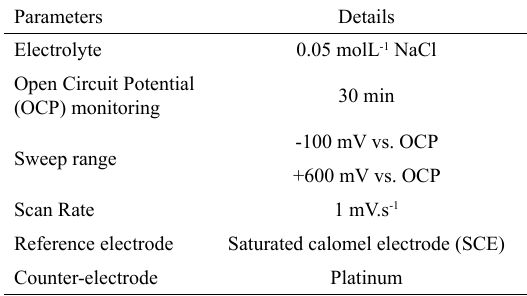
Table 3. Parameters used for potentiodynamic polarization tests.